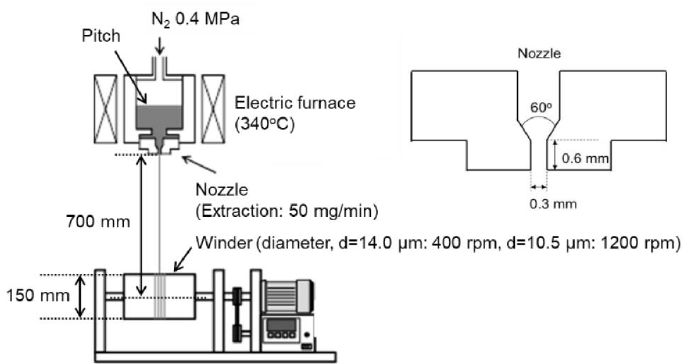
Figure 1. Schematic picture of the self-designed laboratory-type mono-hole melt spinning apparatus.